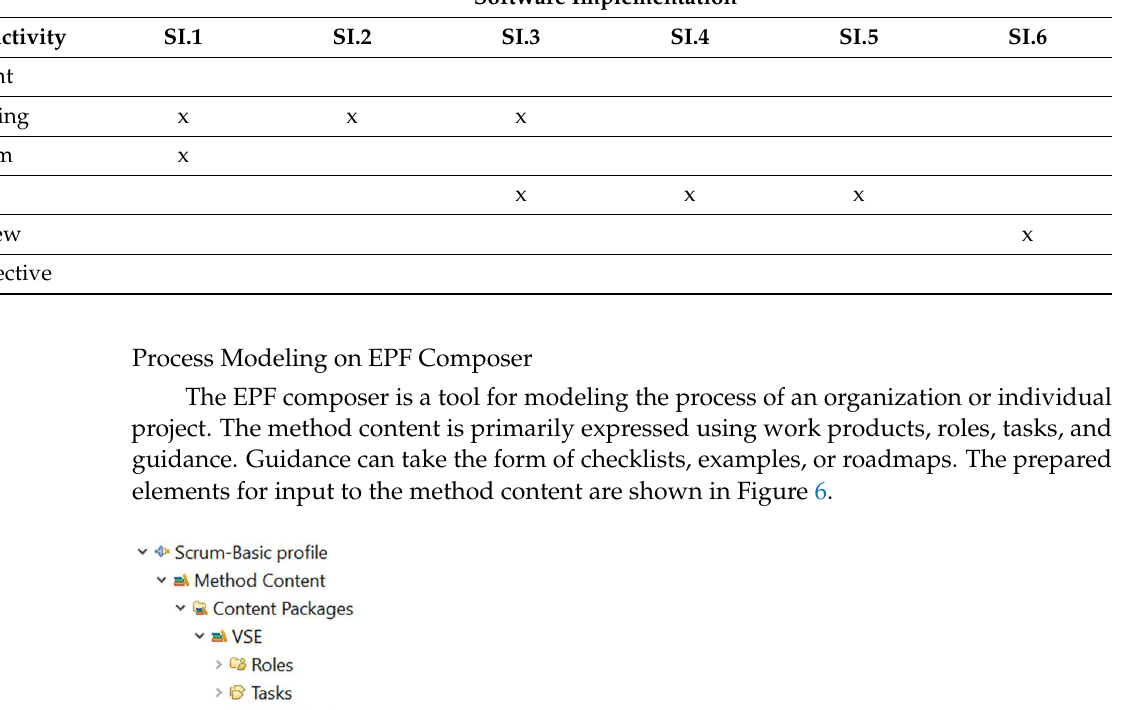
Figure 7. Defined roles in the modeling.